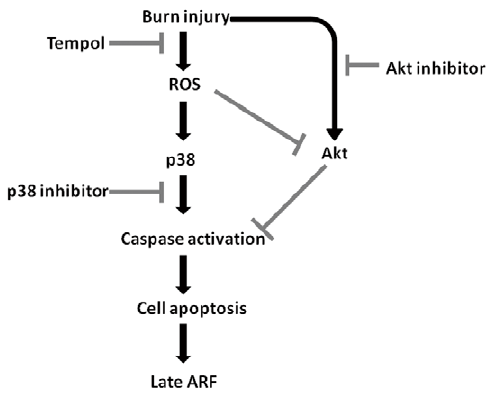
Figure 7. Schematic diagram showed the mediation of burn- induced sustained ROS overproduction on p38 MAPK and Akt expression and apoptotic pathway, which may be the mech- anism of late acute renal failure.